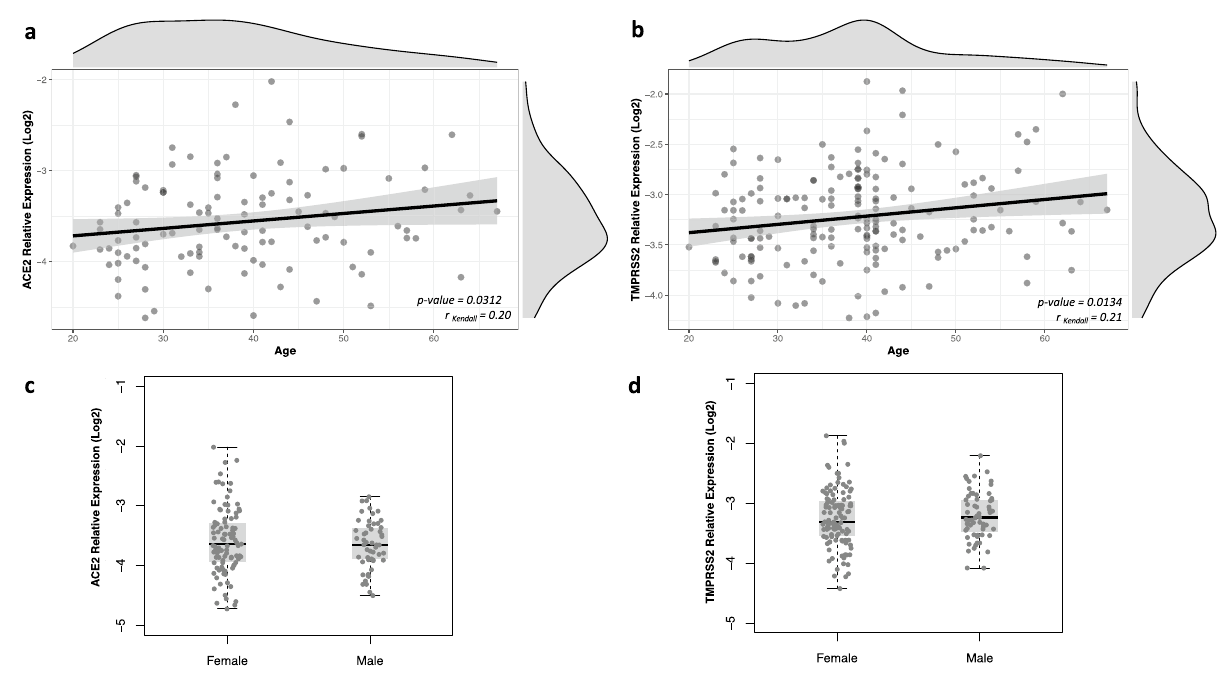
Figure 1. ACE2 and TMPRSS2 expression in nasopharyngeal samples from SARS-CoV-2 positive individuals according to age and sex. Relative expression of both genes was determined by RT-qPCR using B2M gene as reference and results are shown in log-scale (base 2). The correlation between ACE2 and TMPRSS2 expression and age (years) was determined by Kendall rank correlation coefficient and density plots for each variable are depicted externally ( a , b ). Boxes represent mean and interquartile range, and whiskers represent upper and lower limit. Linear regression models were applied for comparisons of ACE2 ( c ) and TMPRSS2 ( d ) expression between male and female